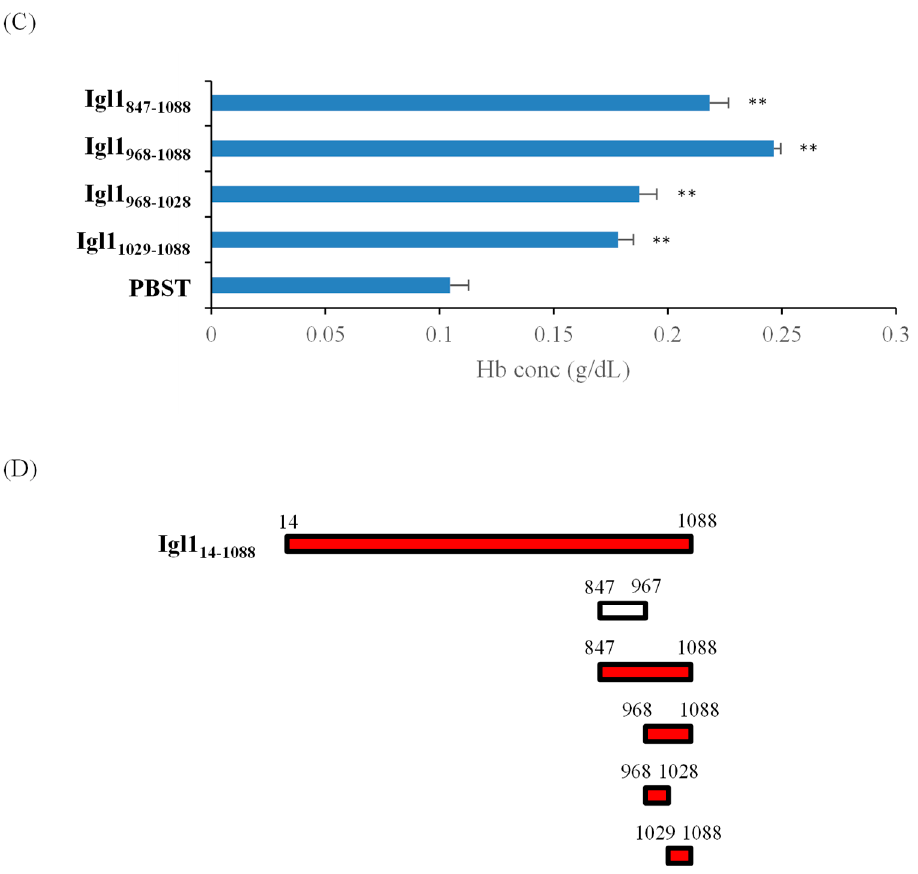
Figure 2. Hemolytic activity of recombinant Igl1 fragment proteins based on Igl1 847-1088 . ( A ) Purities and amounts of recombinant proteins were confirmed by SDS-PAGE, with 1 μ g of each protein run on the gels. ( B ) HoRBCs were incubated with Igl1 fragment proteins in a 96-well plate for the indicated periods. Representative images of 5 independent studies are shown. ( C ) Concentrations of hemoglobin (Hb) released in the supernatant of samples incubated for 6 h. Data are the mean + SD from 5 independent experiments. Hemolytic activities of Igl1 fragments shown in bars with asterisks were significantly higher than that of PBST (** p < 0.01 by ANOVA with a Dunn test). ( D ) Summary of data for fragment proteins with hemolytic activities. Recombinant Igl1 fragments with hemolytic activity are shown in red bars. The open bar (Igl1 847-967 ) indicates a fragment without activity (Figure